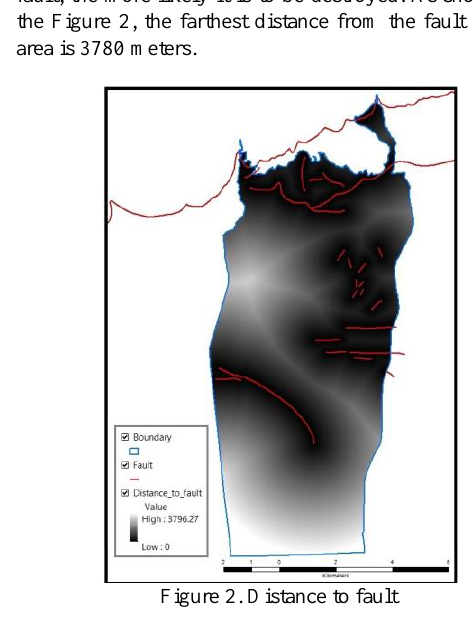
 Building structure type layer: The buildings in the study area classification into 4 classes of concrete, metal, masonry, adobe and wood (Figure 5). The amount of damage to each building depends on the strength of the